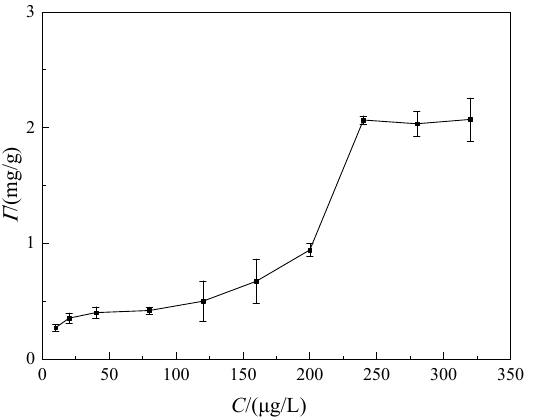
Figure 5. Relationship between the adsorption capacity and the concentration of welan gum solution.